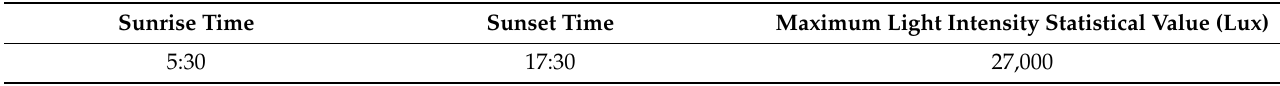
Table A5. Parameters of the interday light components in Scenario I in the case study.